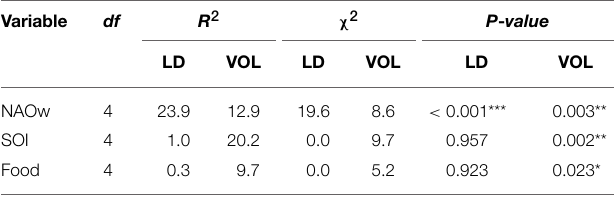
TABLE 2 | Percentages of variance explained by each environmental covariable for each breeding parameter and likelihood ratio test values (see Materials and